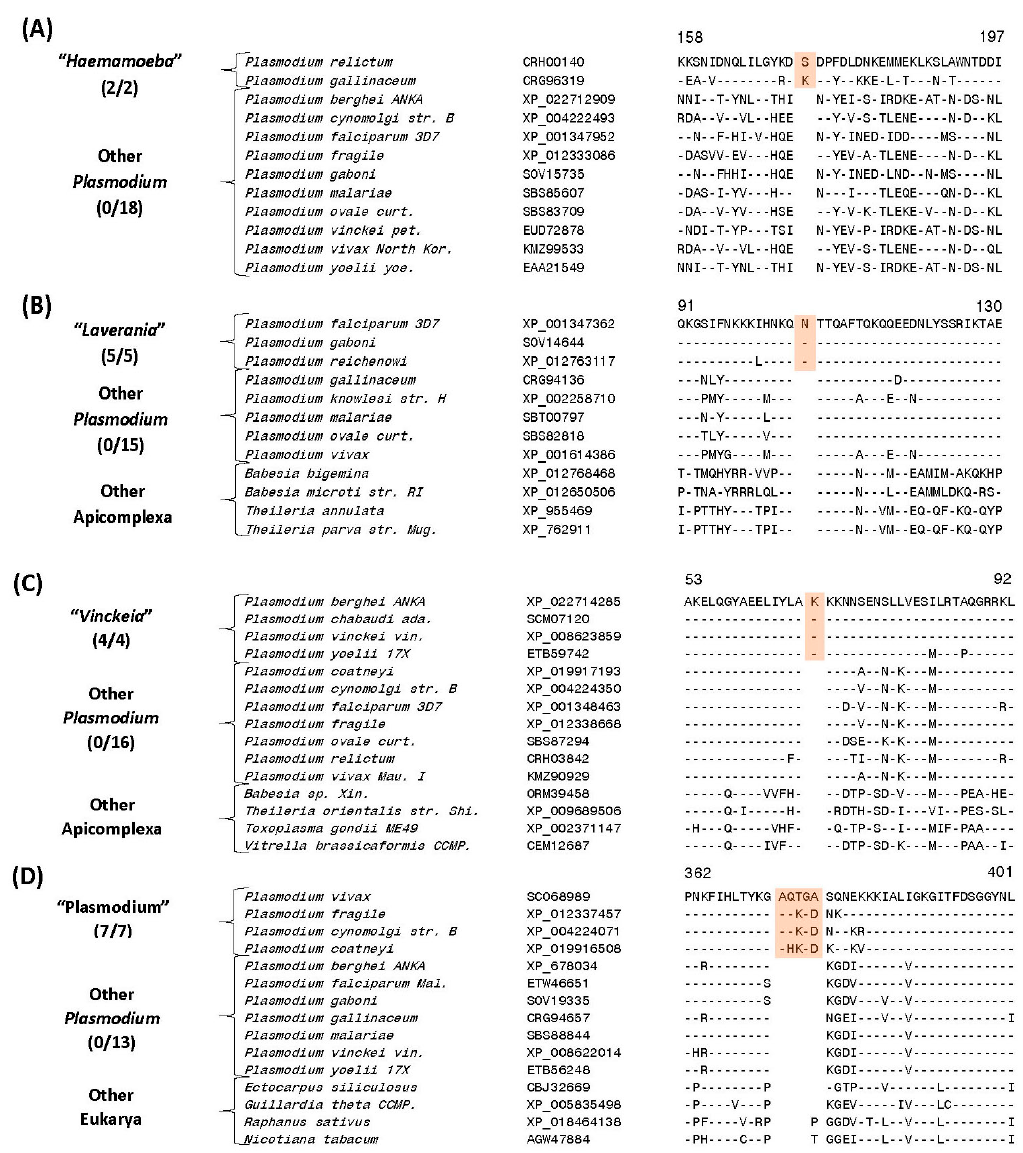
Figure 5. Examples of CSIs that are specific for different groups/subgenera of Plasmodium species (A) Partial sequence alignment of a protein phosphatase showing a 1-aa insertion that is specific for the subgenus Haemamoeba . (B) Partial sequence alignment of the eukaryotic translation initiation factor 3 (subunit D) showing a 1-aa insertion that is specific for members of the subgenus Laverania . (C) Partial sequence alignment of the mitochondrial ribosomal protein L17-2 showing a 1-aa insertion that is specific for the subgenus Vinckeia . (D) Partial sequence alignment of the protein leucine aminopeptidase containing a 5-aa insertion exclusively found in members of the subgenus Plasmodium except P. ovale and P. malariae . Sequence alignments for multiple other CSIs that are also specific for these subgenera are provided in Figures S41, S60–S66 and information for them is summarized in Table 3.